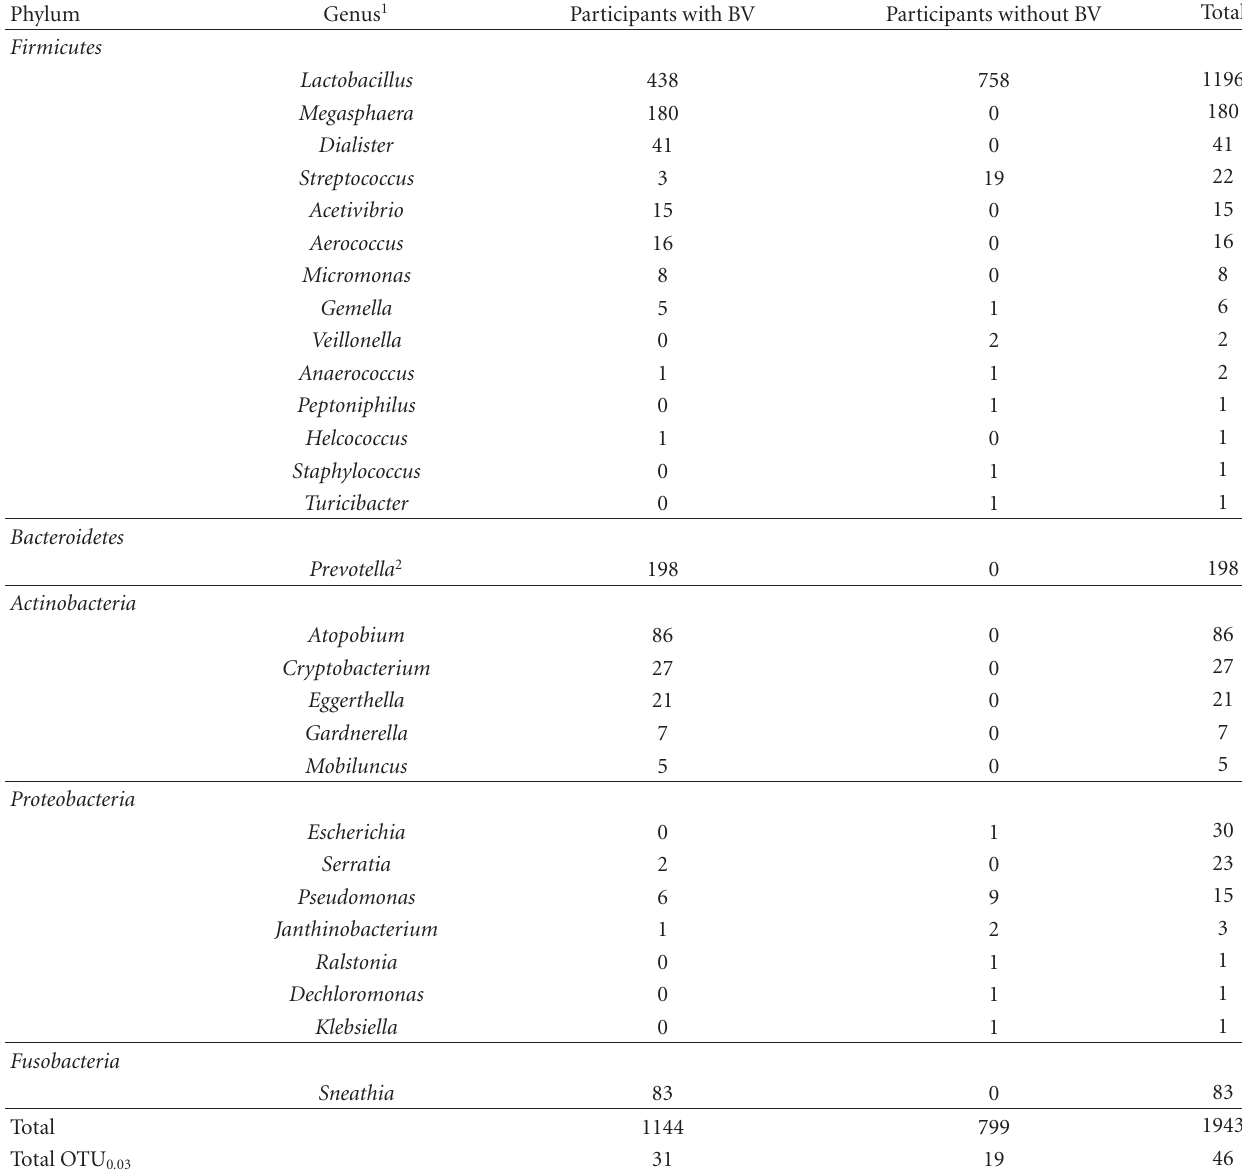
Table 3: Phylogenetic a ffi liation of 16S rRNA gene clones obtained from participants with and without bacterial vaginosis.